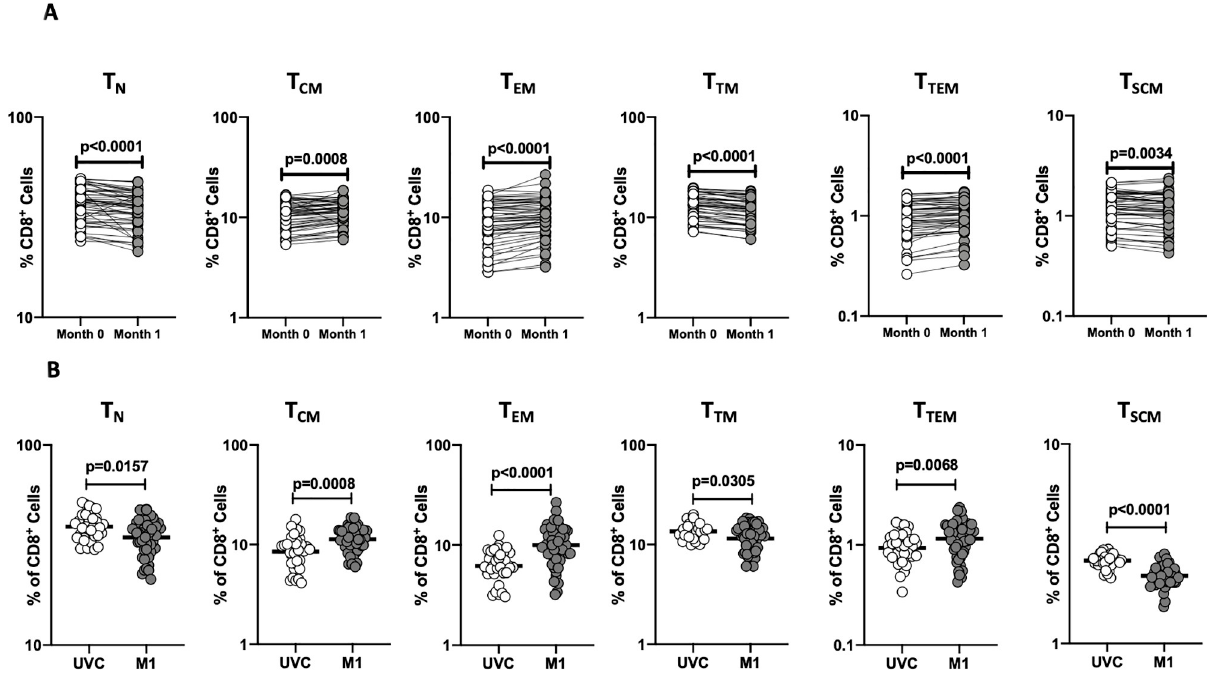
Fig 2. BCG vaccination is associated with altered frequencies of CD8 + T cell memory subsets. (A) Frequencies of CD8 + T cell subsets in BCG pre- vaccinated [M0] (n = 54) and month 1 following vaccination [M1] (n = 54). Data are shown as line diagrams with each line representing a single individual. p values were calculated using the Wilcoxon matched pair tests with Holms correction for multiple comparisons. (B) Frequencies of CD8 + T cell subsets in BCG unvaccinated (UVC) (n = 32) and post vaccinated [M1] (n = 54) individuals. The data are represented as scatter plots with each circle representing a single individual. p values were calculated using the Mann-Whitney test with Holm’s correction for multiple comparisons.